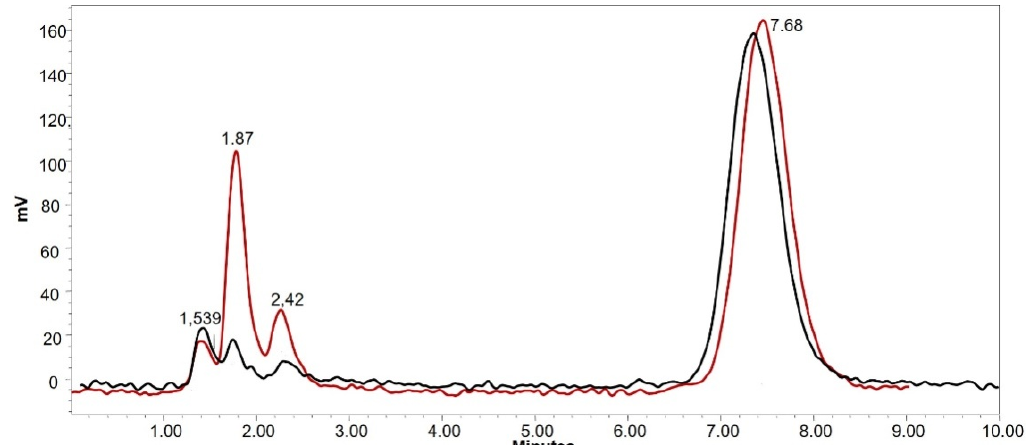
Figure 4. Superimposed HILIC-FL chromatograms obtained from the analysis of a quality control sample at 1 µ g mL − 1 (black line) and of an octreotide injection form sample at 1 µ g mL − 1 (red line). Chromatographic conditions: BEH XBridge ® -HILIC analytical column; mobile phase acetonitrile/8.6 mM (pH 8.1) aqueous solution of ammonium bicarbonate (65:35, v/v ); flow rate—0.25 ml min − 1 .